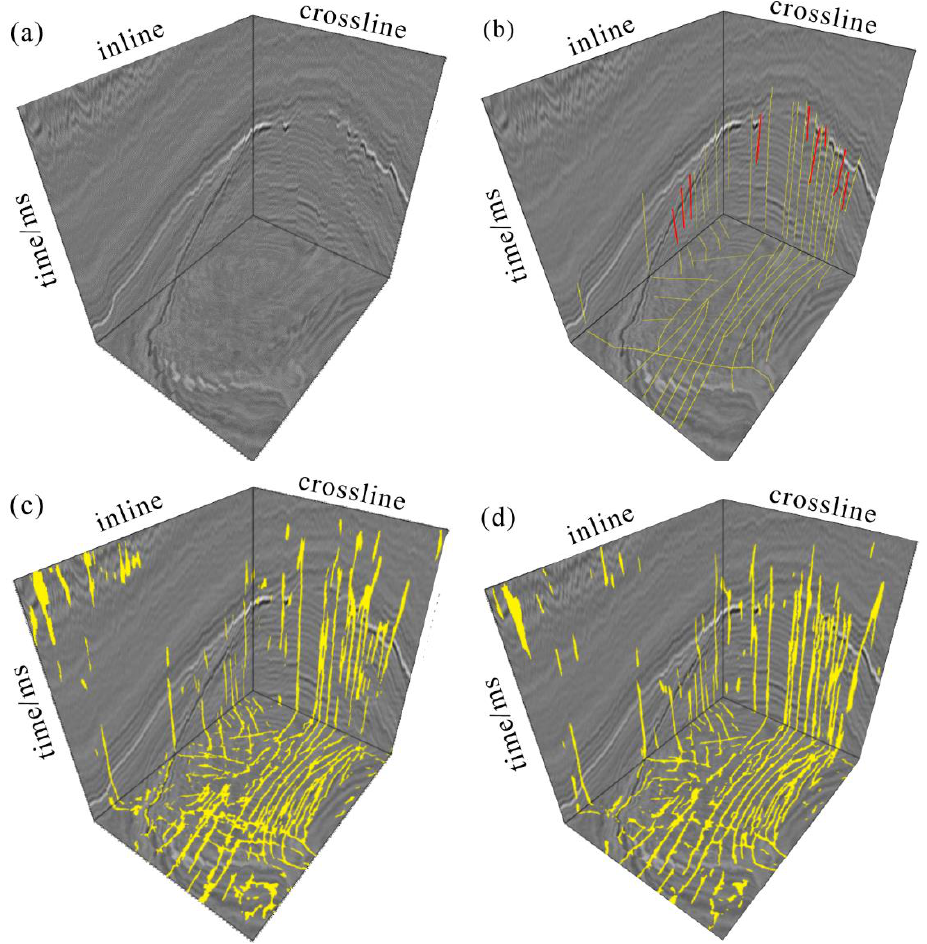
Figure 12. Fault prediction results of real data. ( a ) Real seismic data; ( b ) manual interpretation of fault results; ( c ) UNet recognition; ( d ) SE-UNet recognition.